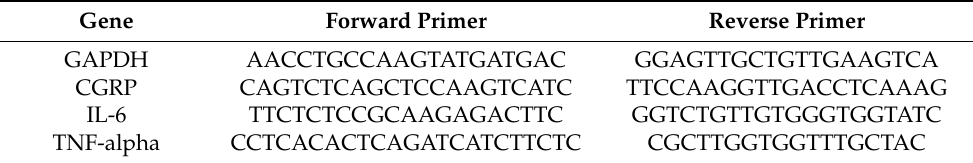
Table 1. This is a table. Tables should be placed in the main text near to the first time they are cited. Gene Forward Primer Reverse Primer